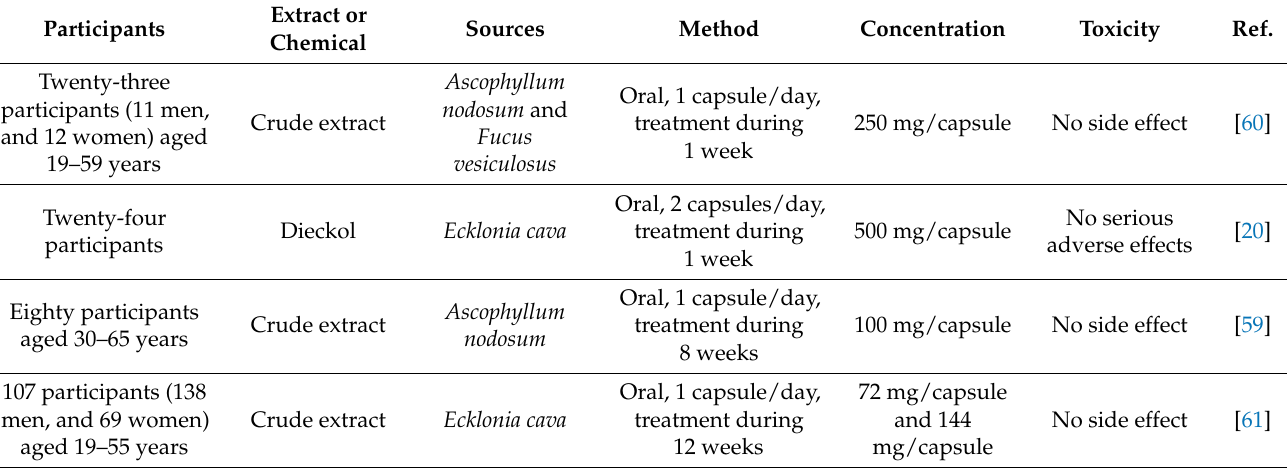
Table 6. Studies of safety and toxicity of phlorotannins extracted from brown seaweeds, as measured in humans.